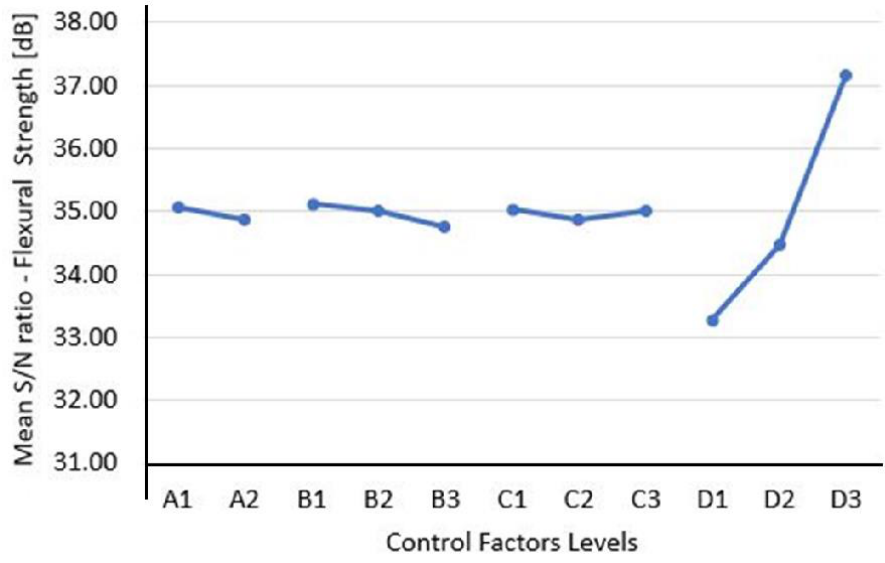
Figure 10. S/N ratio response graph for flexural strength.